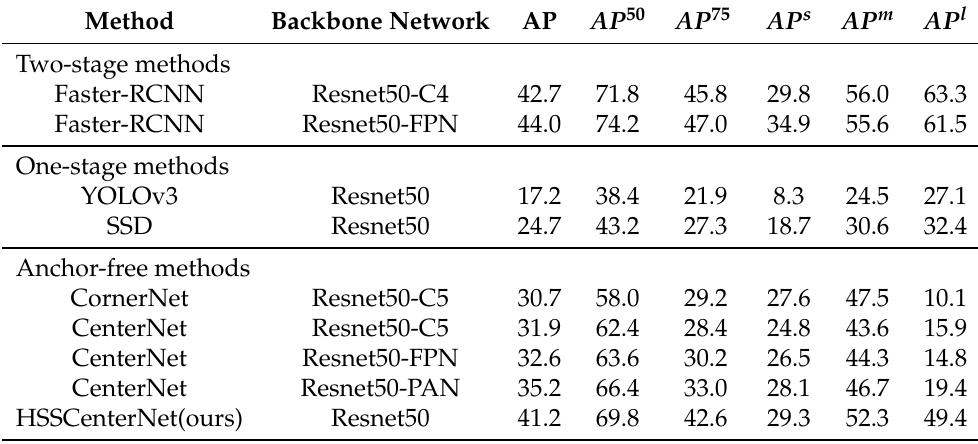
Table 7. Comparison of experimental results on the test set of WHUCS ship